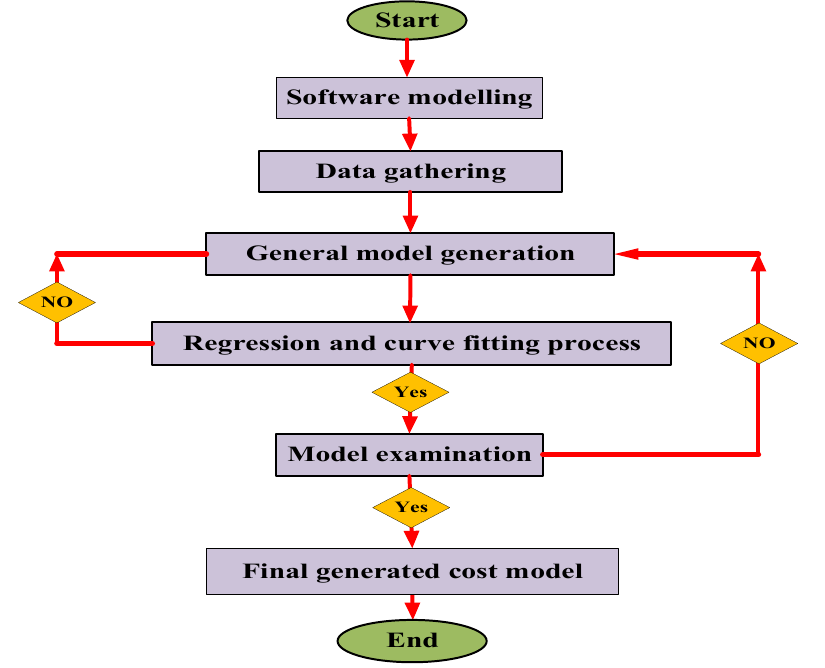
Figure 2. Flowchart of cost model generation.